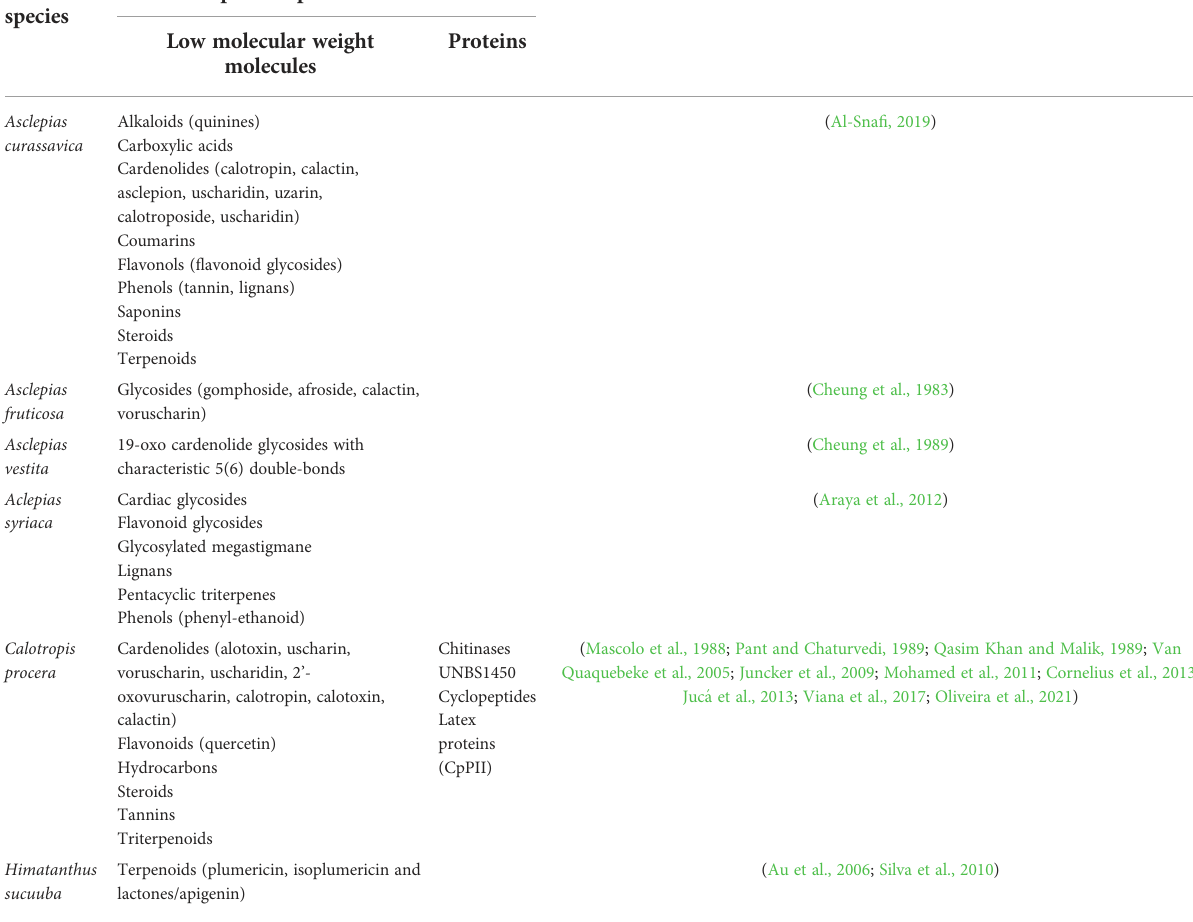
TABLE 1 Biological compounds with potential anticancer activity present in the latex of Apocynaceae family